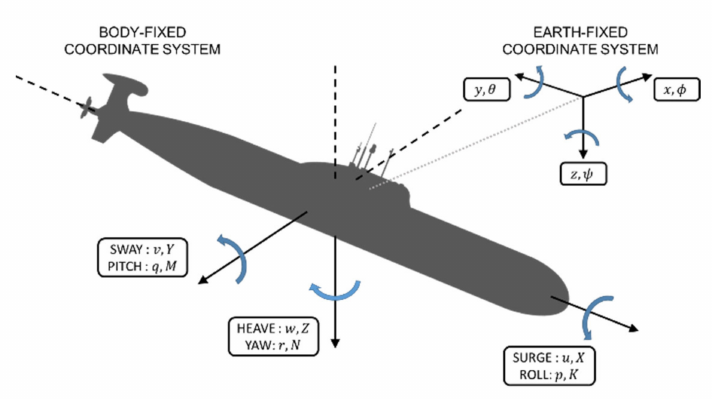
Figure 1. Coordinate systems representation of